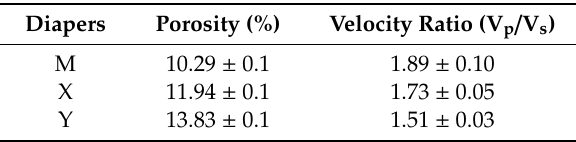
Table 3. Physical properties of layers M, X and